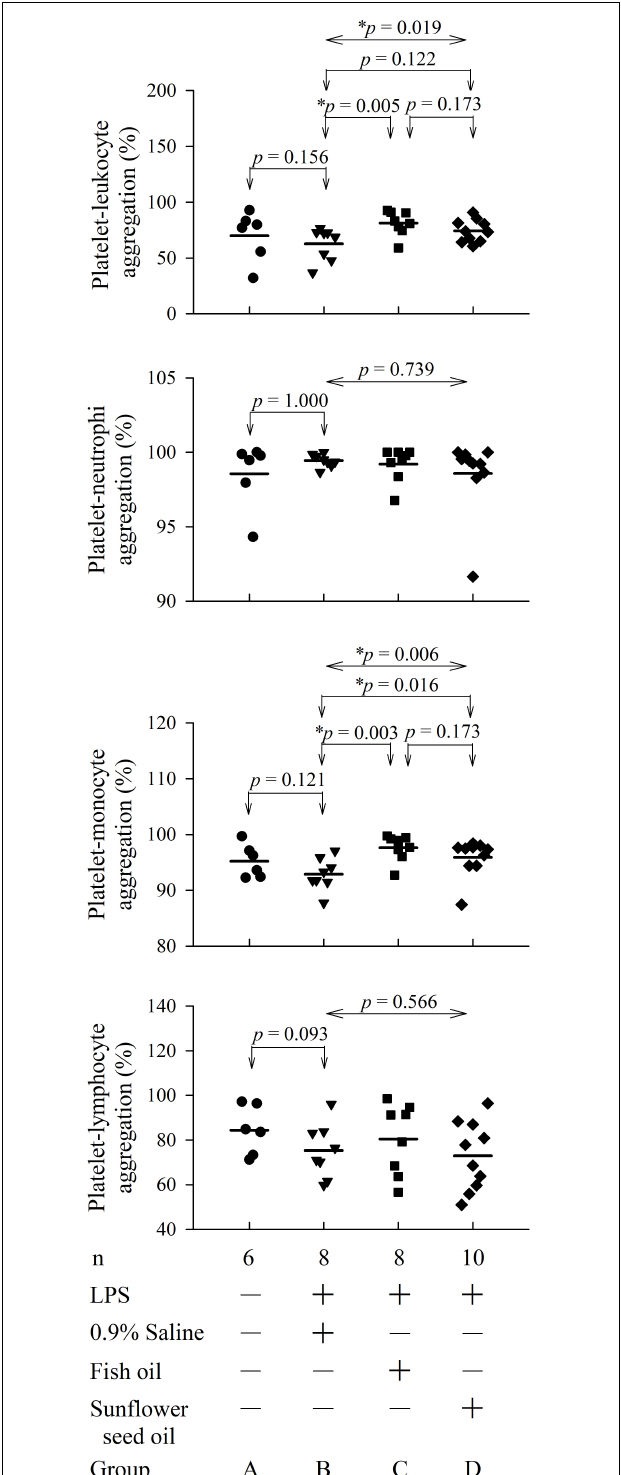
FIGURE 3 | Effects of dietary supplementation of fish oil and sunflower seed oil on platelet-leukocyte aggregation and its subpopulations in endotoxemic rats. Data are expressed as mean ± SD. LPS, lipopolysaccharide; n, number of rats that survived. ∗ p <